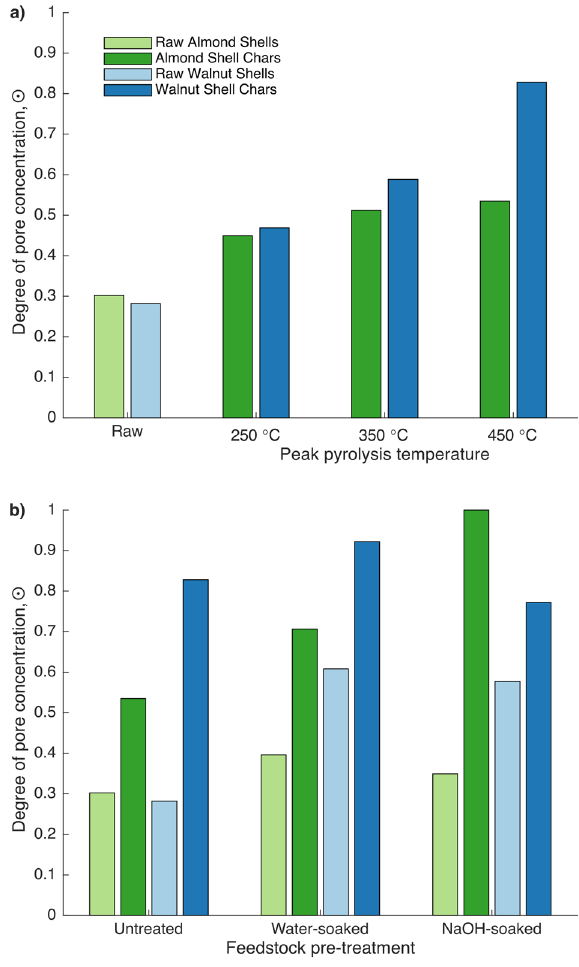
Figure 7. Degree of pore concentration, ⨀ , of ( a ) untreated raw biomass and biochar beds by peak pyrolysis temperature and feedstock and ( b ) raw biomass and biochar beds produced at a peak pyrolysis temperature of 450 °C by pretreatment method and